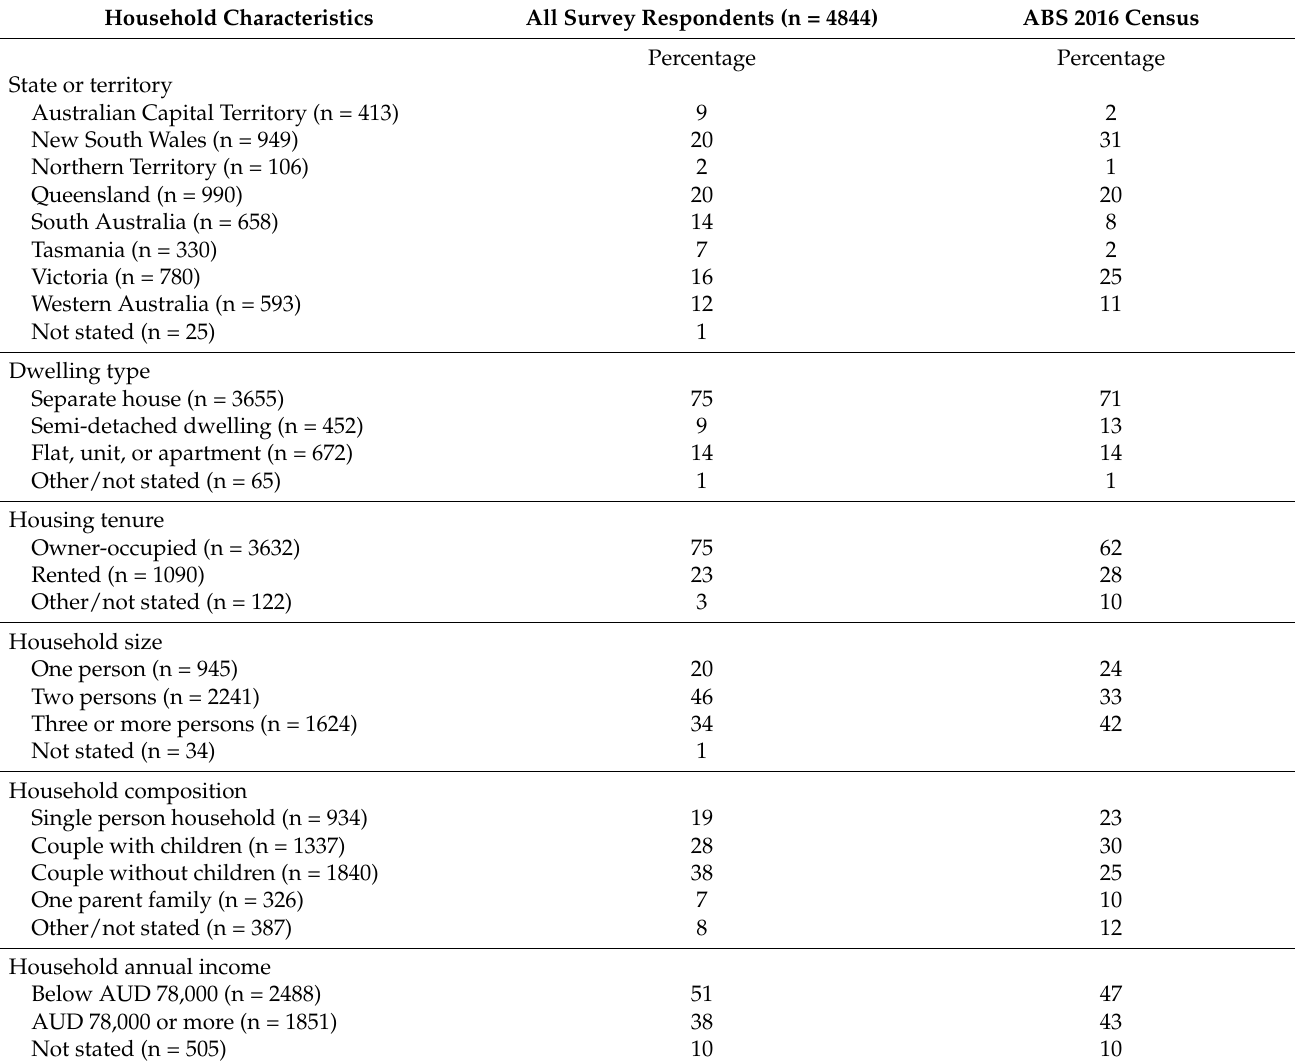
Table 2. Household characteristics of survey sample vs. national census: sample